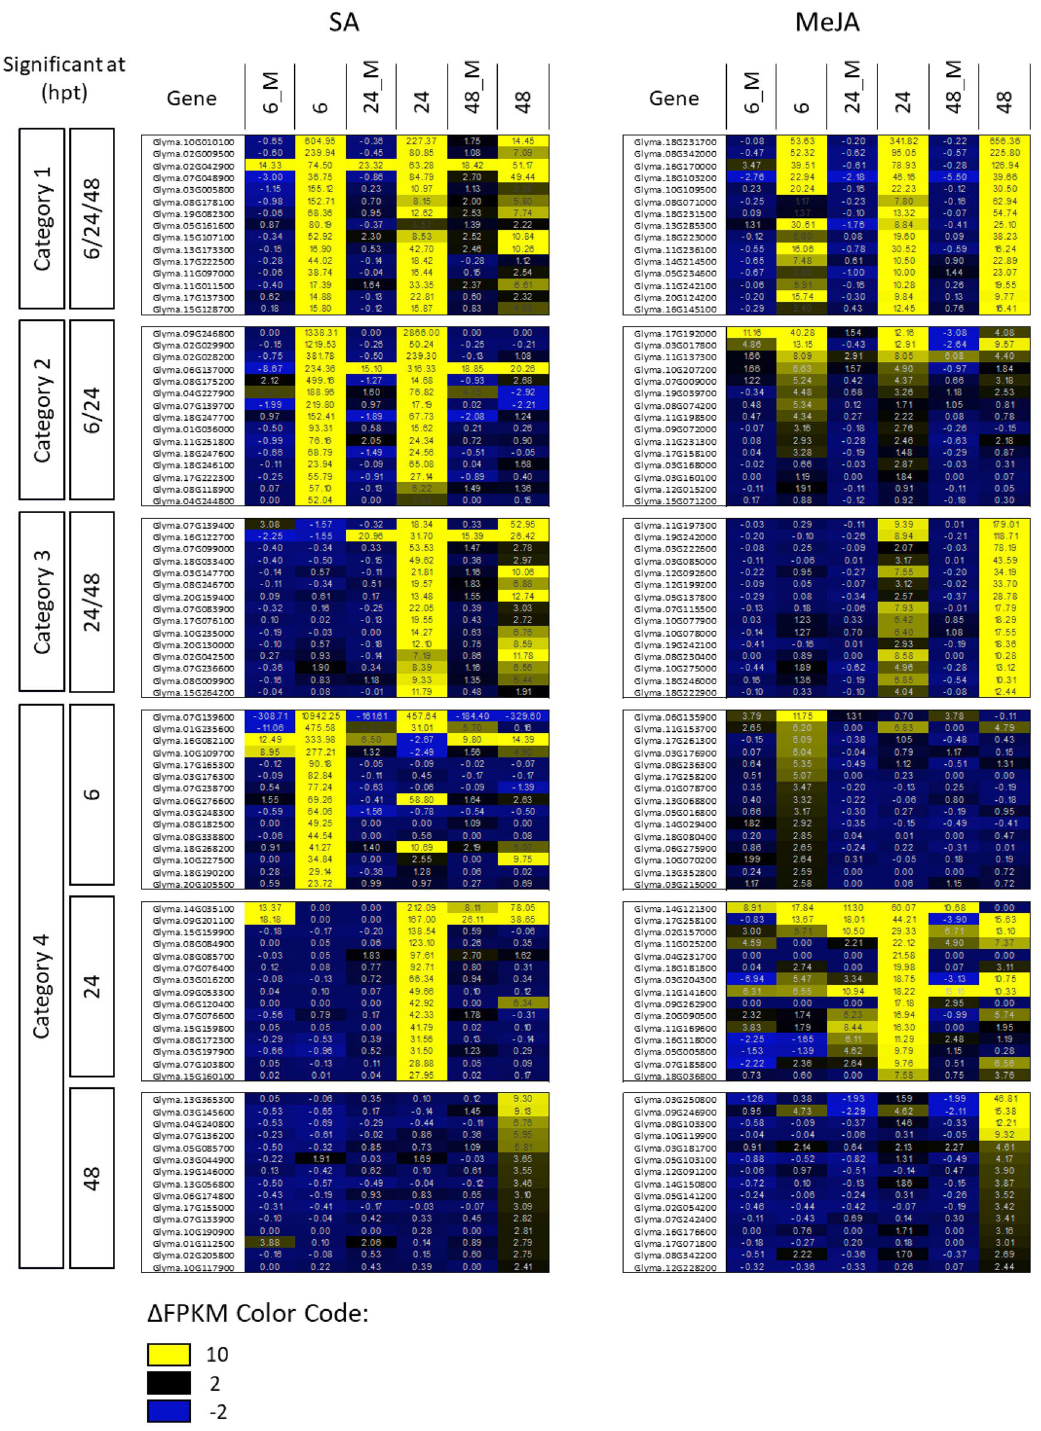
Figure 2. SA or JAs-responsive soybean genes classified by their temporal induction pattern. Leaf transcriptomes were recorded by RNA-seq in SA, MeJA, mock (M)-treated or untreated soybean leaves at the indicated time points. Specified are genes with significantly (p ≤ 0.01) induced expression after treatment with either SA or MeJA for more than one (category 1–3) or at a single time point of sampling (category 4) compared to untreated controls. In addition, only those genes were included that were not significantly differently expressed among untreated and mock-treated samples. Numbers correspond to ΔFPKM values that were highlighted according to the displayed color